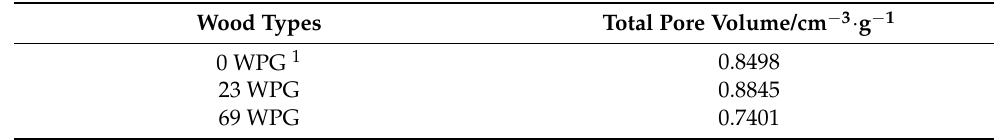
Table 2. Total pore volume by nuclear magnetic resonance cryoporometry. Wood Types